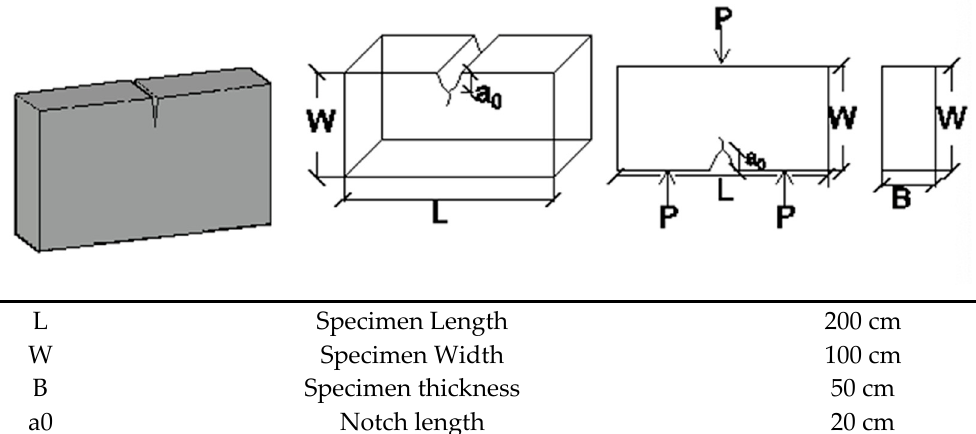
Figure 1. Detailed schematics for single edge notched bend (SENB) specimens.